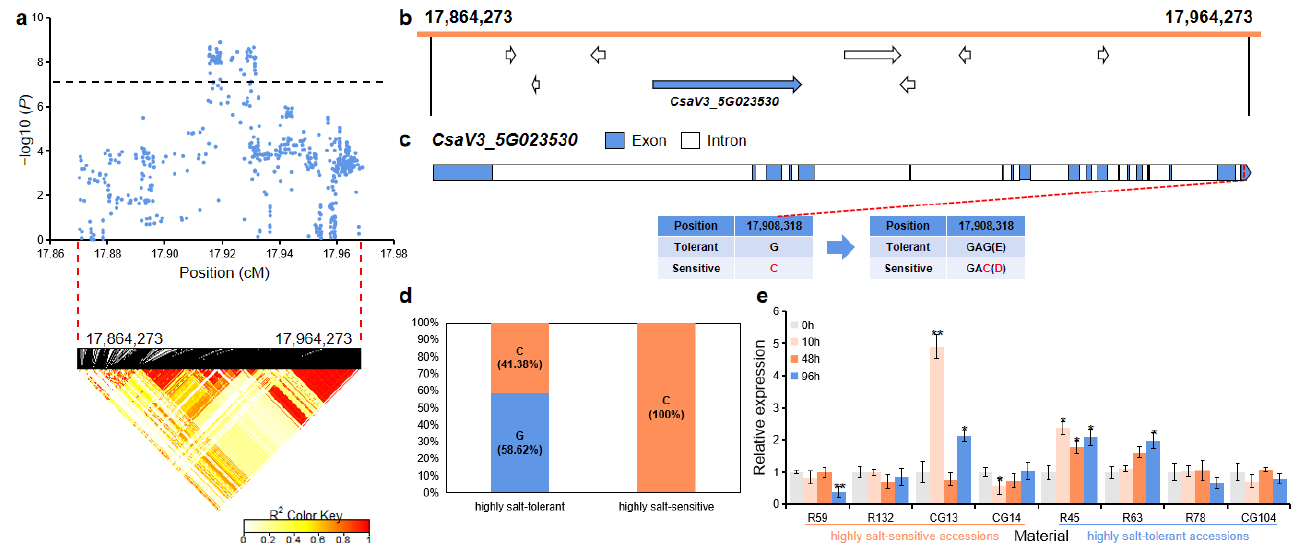
Figure 8. Identification of the candidate gene that was related to salt tolerance for the locus gST5.1 . ( a ) Manhattan plot and LD heatmap of gST5.1 . The black dashed line represents the significance threshold and the red dashed lines represent the candidate region (100 kb). ( b ) A total of eight functional annotated genes were predicted in the gST5.1 candidate region. The blue arrow indicates that the functional annotation of the gene which is related to salt tolerance. ( c ) The gene structure of CsaV3_5G023530 . Blue rectangles and white rectangles indicate exons and introns, respectively. ( d ) Orange and blue blocks represent the proportion of C and G haplotypes in the highly salt-tolerant or highly salt-sensitive accessions, respectively. ( e ) qRT-PCR was used to detect the expression changes of CsaV3_5G023530 in the highly salt-sensitive accessions (R59, R132, CG13, and CG14) and highly salt-tolerant accessions (R45, R63, R78, and CG104) after salt treatment (0 h, 10 h, 48 h, and 96 h). Significant difference (* p < 0.05, ** p < 0.01).